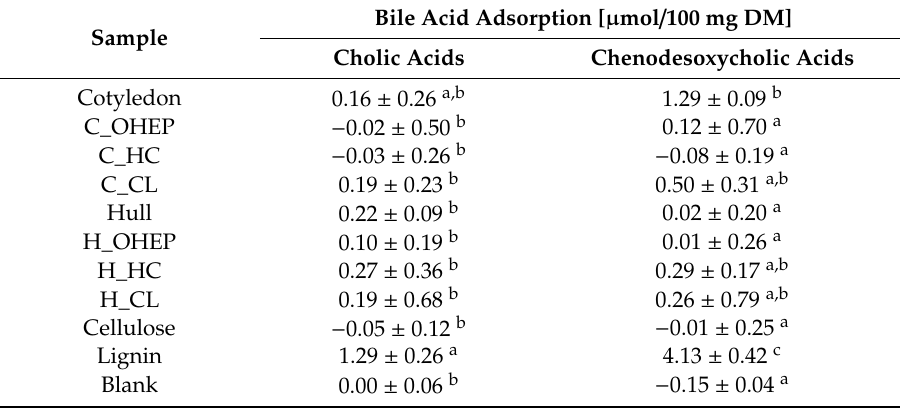
Table 4. Bile acid adsorption (given as sum of glyco- and tauroconjugated cholic acids and chenodesoxycholic acids) of in vitro digesta containing fractionated dietary fibre (pectin-like fraction (OHEP), hemicellulose fraction (HC), cellulose-lignin fraction (CL)) derived from lupin cotyledon and hull of L. angustifolius L. Boregine, cellulose and lignin ( n = 3). Bile Acid Adsorption [ µ mol / 100 mg DM] Sample Cholic Acids Chenodesoxycholic